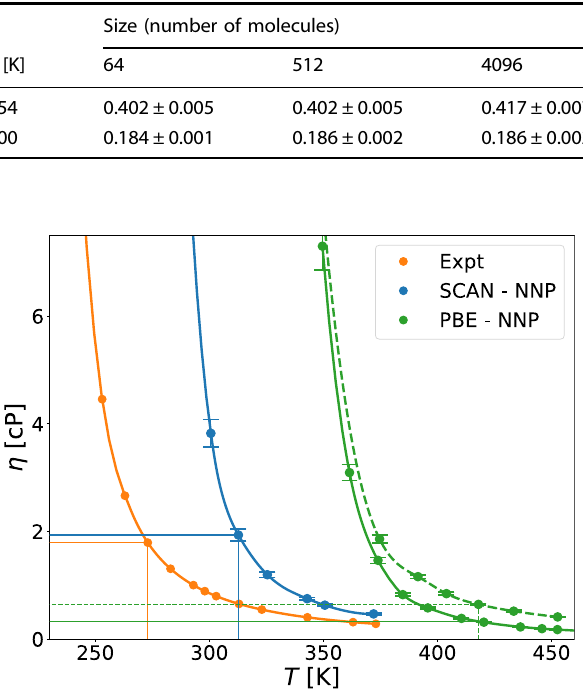
Fig. 8 Comparison between the shear viscosities of water computed via DPMD simulations using NNP force fi elds trained to different DFT datasets and with experiments 85,86 . When not visible, the error bars are smaller than the dots. Continuous lines refer to simulations performed at the equilibrium density corre- sponding to each temperature. PBE data marked with a dashed line are obtained at the density of 1 gr cm − 3 . The thin vertical and horizontal lines mark the melting temperature and the correspond- ing viscosities. Error bars represent standard deviations.